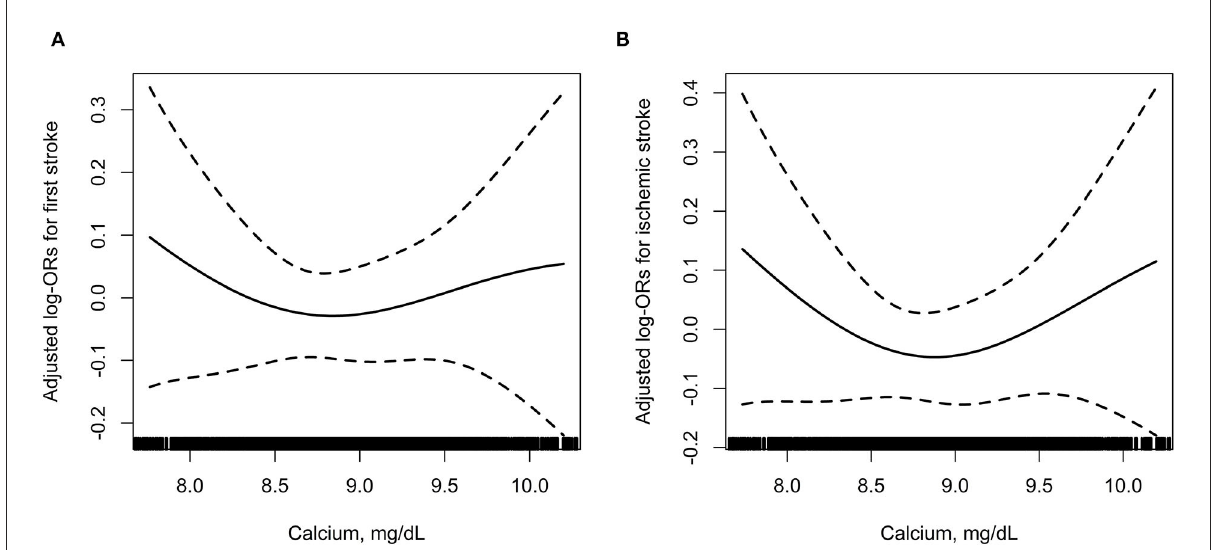
FIGURE2 The association between baseline serum albumin-corrected calcium and incident risk of first total stroke (A) and ischemic stroke (B) . In addition to the matching factors (age, sex, and study village), the splines also adjusted for BMI, SBP, DBP, smoking status, drinking status, labor intensity, total cholesterol, triglycerides, HDL-C, fasting glucose, total homocysteine, eGFR, phosphate, 25(OH)D 3 , magnesium, antihypertensive drugs, glucose-lowering drugs, lipid-lowering drugs, and antiplatelet